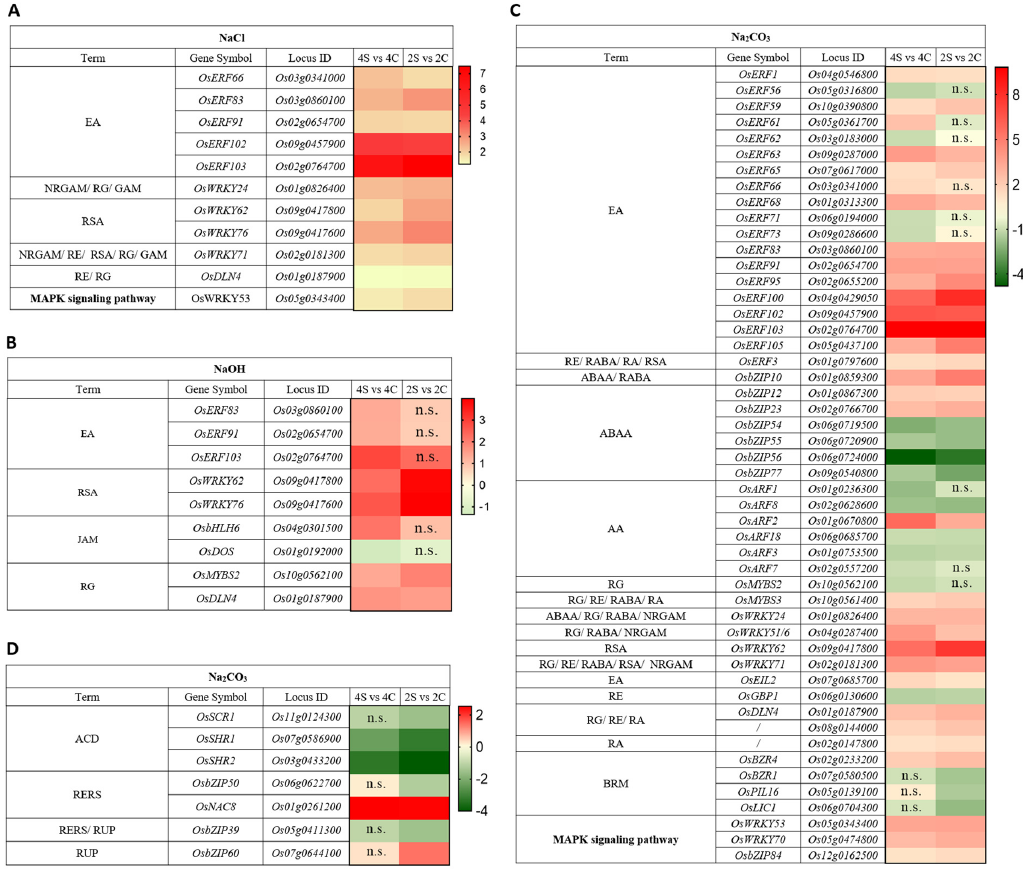
Figure 3. Heatmap analysis of DE-TFs under NaCl, NaOH, and Na 2 CO 3 stress conditions. Heatmap of DE-TFs enriched in hormone signals and MAPK signaling pathway ( A – C ), and biological processes including ACD, RERS and RUP ( D ). The genes marked with a blue star are involved in the MAPK signaling pathway. DE-TFs: differentially expressed transcription factors; n.s.: no significance; EA: ethylene-activated signaling pathway; NRGAM: negative regulation of gibberellic acid-mediated signaling pathway; RG: response to gibberellin; GAM: gibberellic acid-mediated signaling pathway; RSA: response to salicylic acid; RE: response to ethylene; JAM: jasmonic acid-mediated signaling pathway; RABA: response to abscisic acid; RA: response to auxin; ABAA: abscisic acid-activated signaling pathway; AA: auxin-activated signaling pathway; BRM: brassinosteroid mediated signaling pathway; ACD: asymmetric cell division; RERS: response to endoplasmic reticulum stress; RUP: response to unfolded protein. 2C and 4C represent diploid and tetraploid plants under control conditions, respectively; 2S and 4S represent diploid and tetraploid plants under three stress conditions,